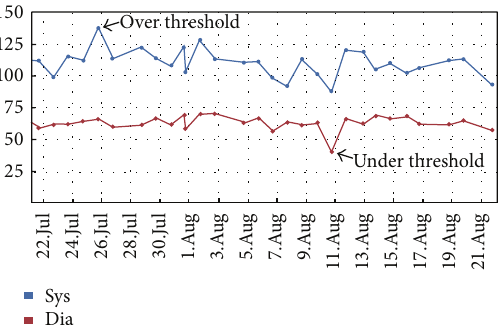
Figure 8: Example of blood pressure analysis of H@H.